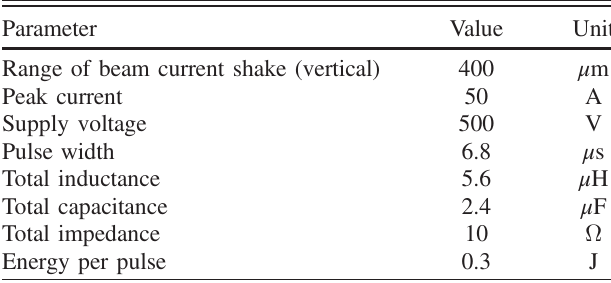
TABLE I. Specification of the fast counterkicker power supply. Parameter